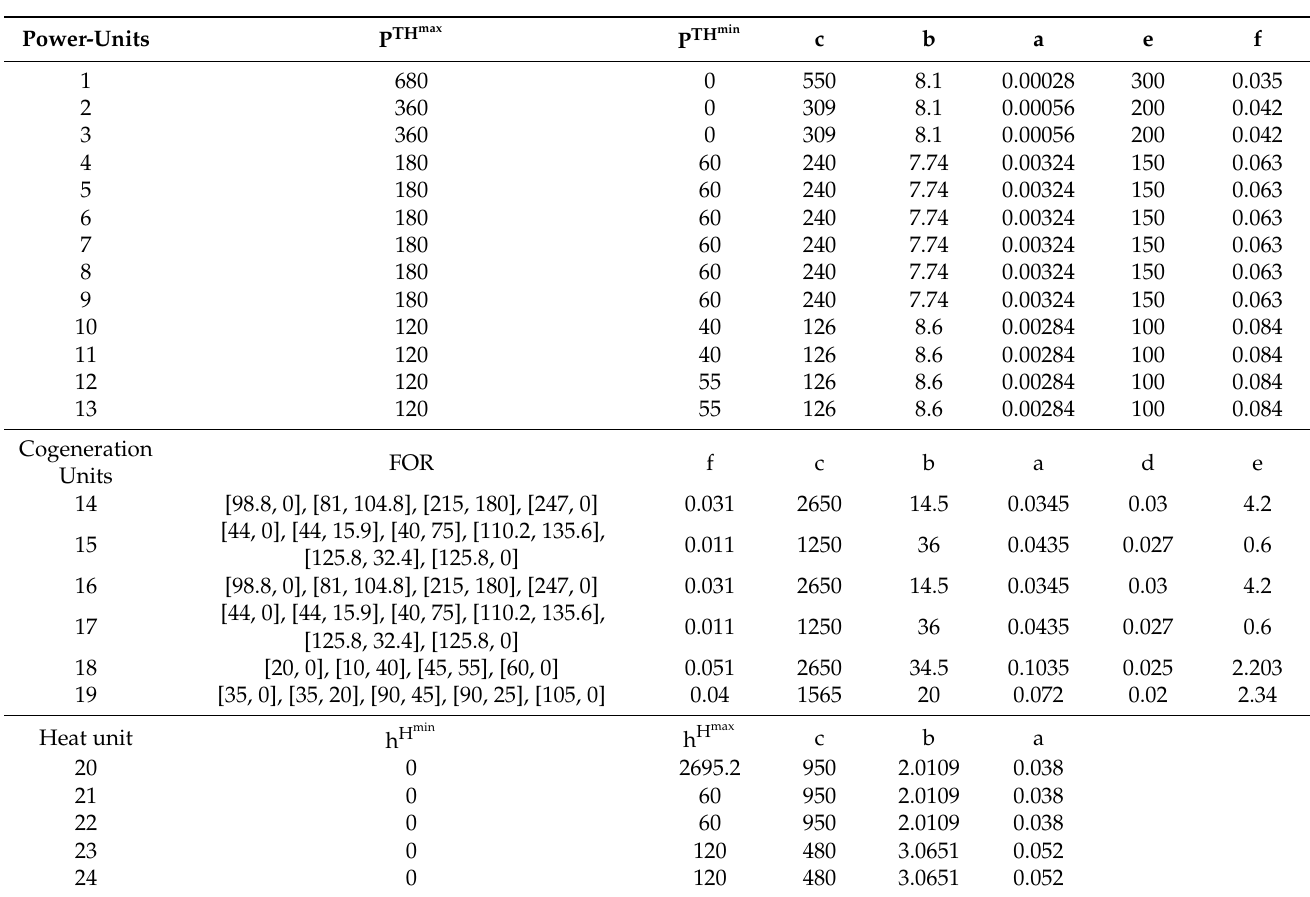
Table A2. Cost function parameters of the twenty-four-unit test